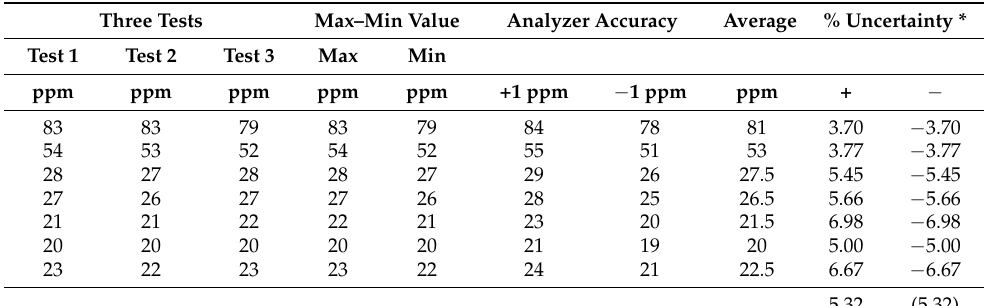
Table 7. Uncertainty calculation for HC emission of palm biodiesel engines for coated 100% Al 2 O 3 · SiO 2